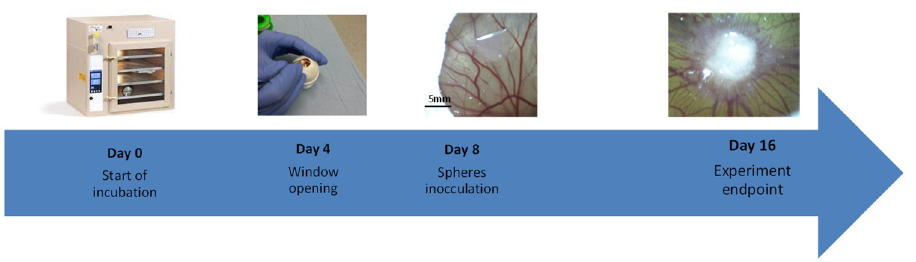
Figure 1. In vivo workflow: A timeline of chorioallantoic member (CAM). Fertilized eggs are incubated for 4 days, at which time a shell window is opened. At embryonic development day 8, tumorspheres are inoculated on top of the CAM. At day 16, the eggs are sacrificed, and the tumor growth is examined.